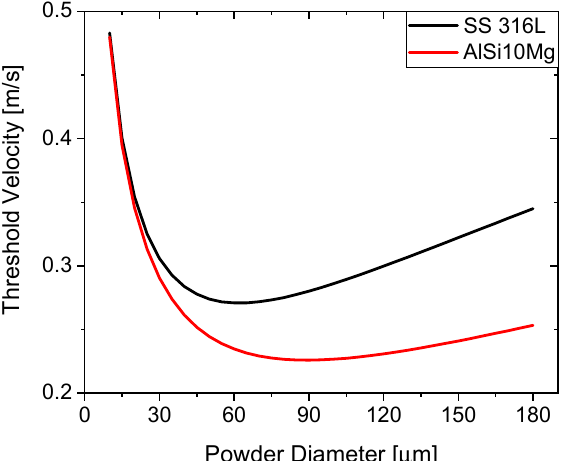
Figure 4. Threshold velocity as a function of powder diameter for two metal powder materials (stainless steel 316L (SS 316L) and aluminum alloy (AlSi10Mg)).